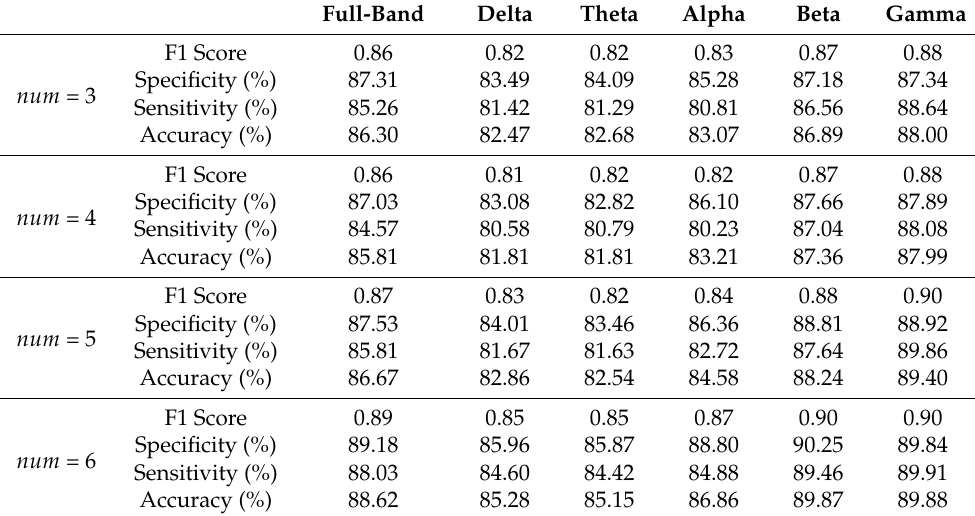
Table 2. This table shows the classification results of the features extracted by tensor decomposition.